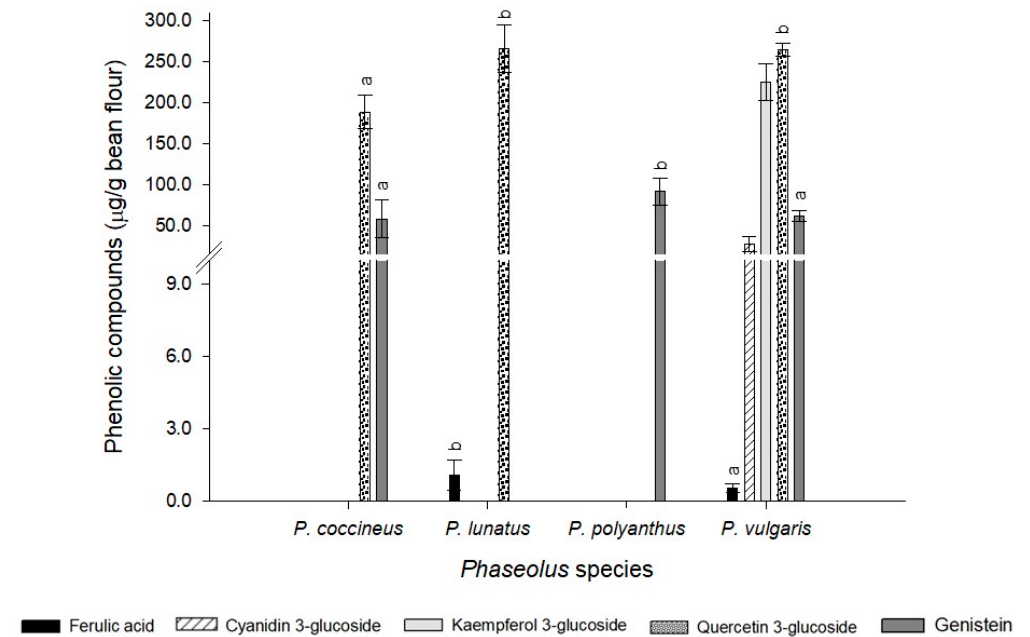
Figure 4. Phenolic compounds analyzed by UHPLC by Phaseolus species. Mean values ± SD with different letters indicate statistically significant differences according to Tukey’ test ( p < 0.05).